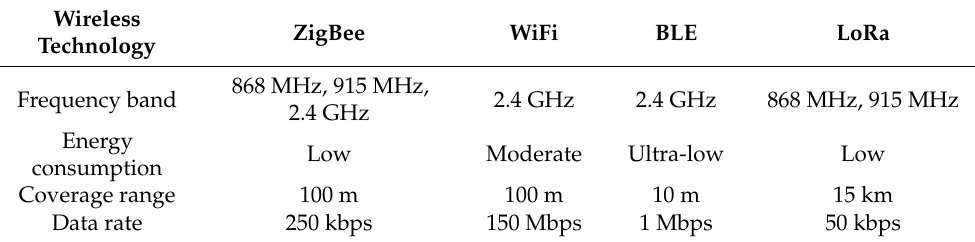
Table 1. Wireless technologies that can be utilized in precision agriculture systems.